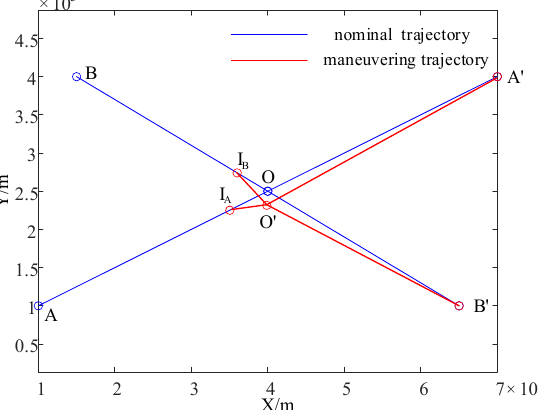
B'O' Figure 8. Trajectory diagram of integrated optimal separation assurance strategy. Table 3. Results of three separation assurance strategies. Separation Assurance Strategy